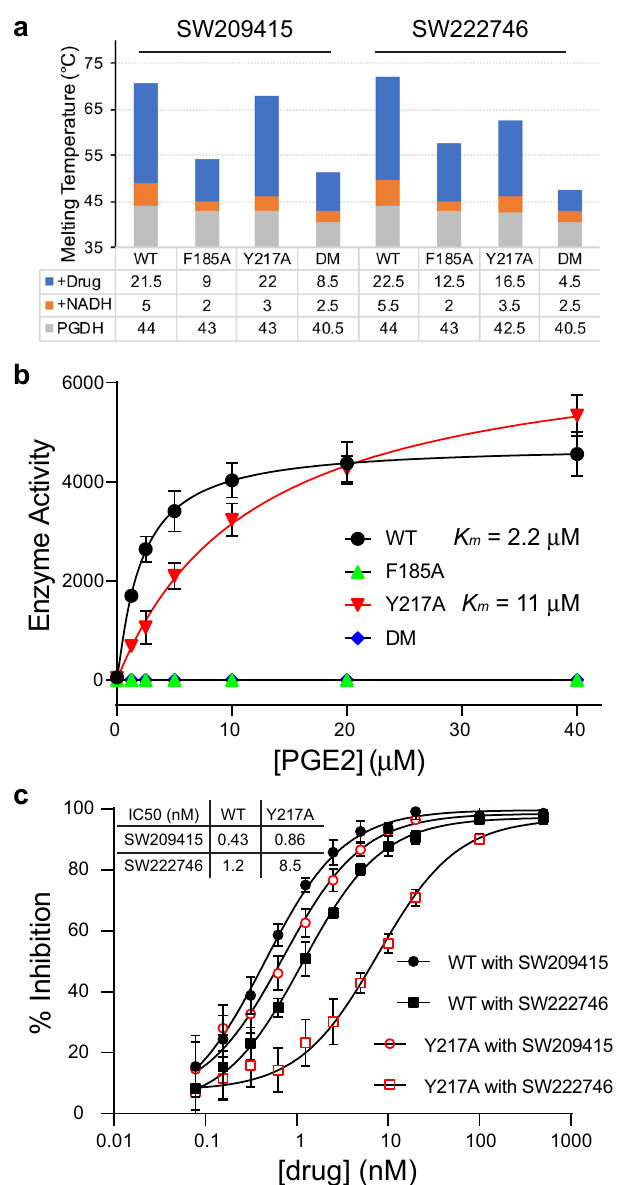
Fig. 5 | Conserved F185 and Y217 residues contribute both to 15-PGDH enzy- matic function and to 15-PGDH binding of inhibitors. a Shown is the melting temperature ( T m ) of wild type and mutant 15-PGDH proteins (gray bar), along with increments of T m acquired upon addition of NADH (orange bar), or upon addition of both NADH plus drug (blue bar). F185A and Y217A are individual point mutants and DM is the F185A+Y217A double mutant. b Michaelis – Menten enzyme kinetics forwildtypeandmutant15-PGDHproteinsinoxidizingPGE2.Wild-typePGDHhasa K m of 2.2 µ M and Hill coef fi cient n H =1.0; the Y217A mutant has a K m of 11 µ M and n H =1.0; andF185A and the doublemutant are both inactive. Data are presentedas mean values ±SD ( n =3). c Percent inhibition (0 – 100%) of wild type and F217A mutant 15-PGDH enzyme activity versus concentration for (+)-SW209415 and SW222746, with a concentration in log scale. At a tested 15-PGDH protein con- centration of 2nM, IC50 values for (+)-SW209415 for wild type and Y217A are 0.43 and 0.86nM, respectively, and IC50 values for SW222746 for wild type and Y217A are 1.2 and 8.5nM,